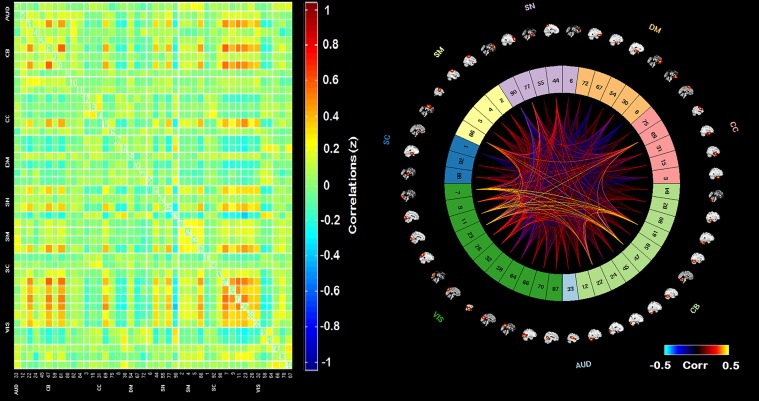
Adjacency matrix and connectogram highlighting the connectivities across subnetworks for state 5.Abbreviations: Aud: auditory network, ECN: executive control network, DMN: default mode network, SM: sensory-motor network, SN: salience network.